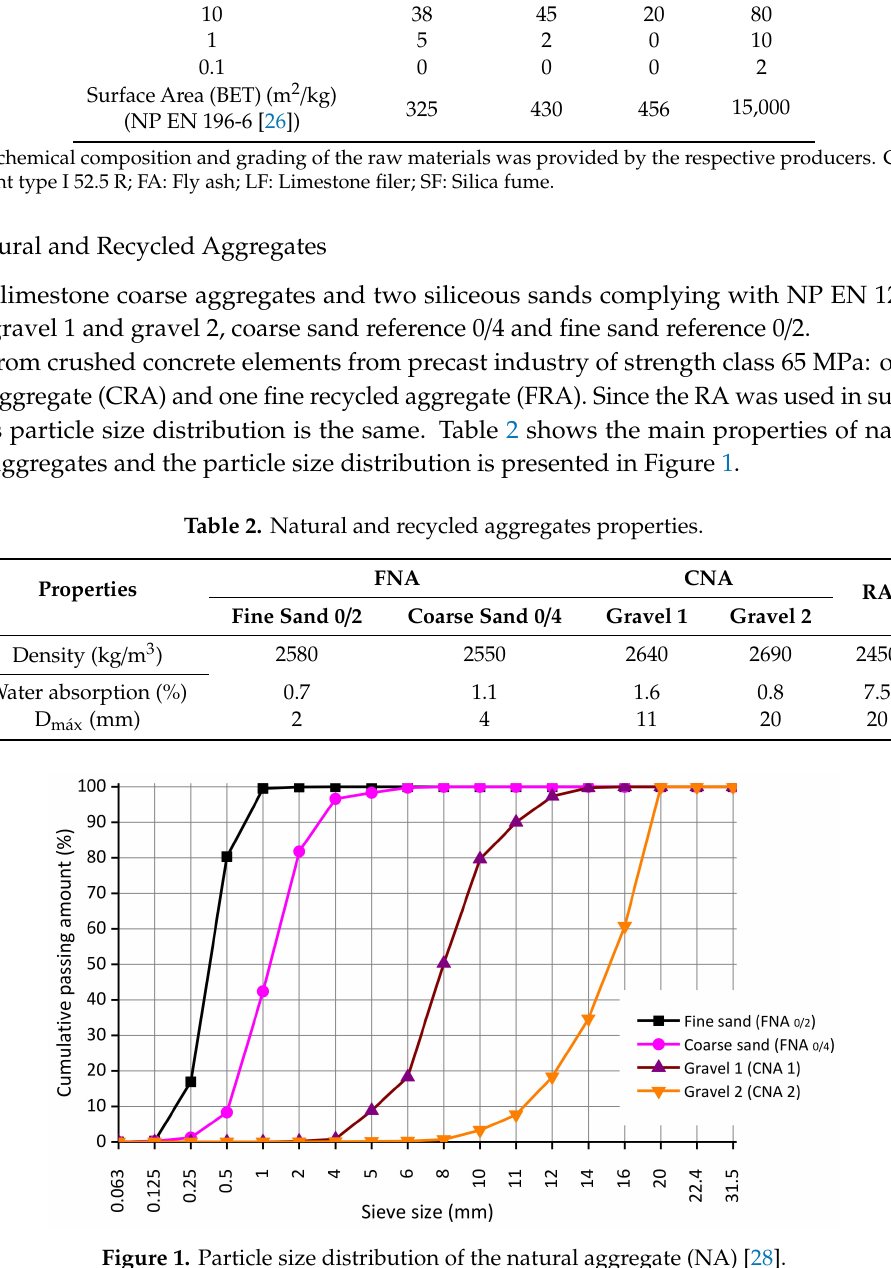
Figure 1. Particle size distribution of the natural aggregate (NA)